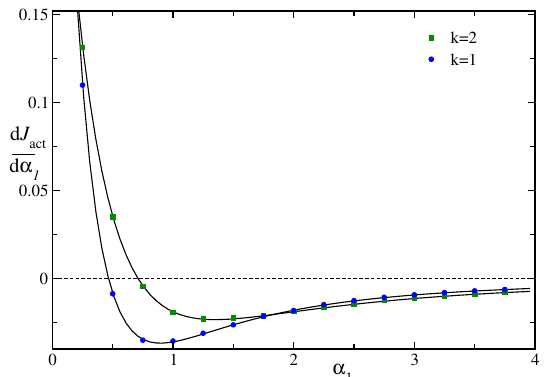
versus α Figure 7: Plot of dJ act for the dichotomous active noise for two different 1 d α 1 values of k : the solid lines show the exact expression obtained from Eq. (A.31) while the symbols show the predicted correlation [ see Eq. (C.4) ] measured from numerical